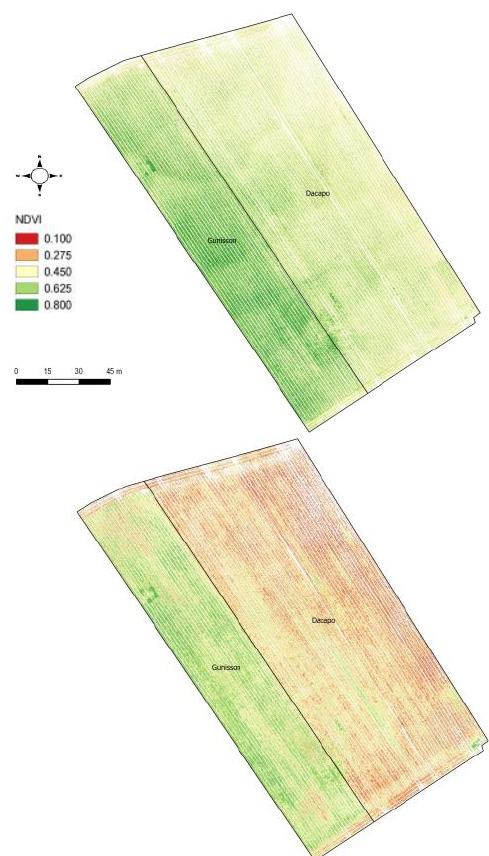
Figure 13. NDVI of an onion field infested by thrips on 16 th July (top) and 31 st July 2014 (bottom); green = vital plants, red = affected plants (Canon S110 NIR, GSD 2.5 cm).